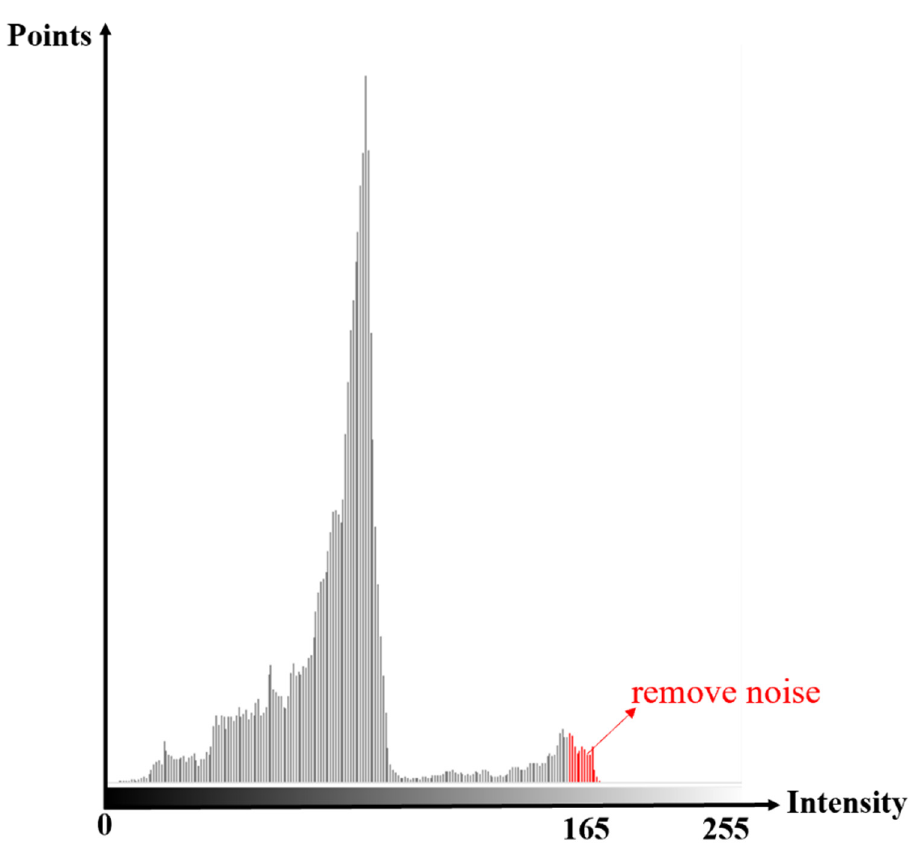
Figure 3. Removal of unusual parts of the intensity values (red parts) by intensity histogram filtering.